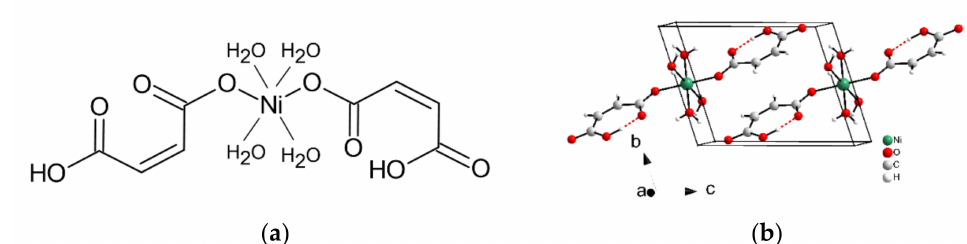
Figure 1. ( a ) Molecular structure of NiHmal; ( b ) Crystal structure of NiHmal. The dashed lines represent hydrogen bonds.